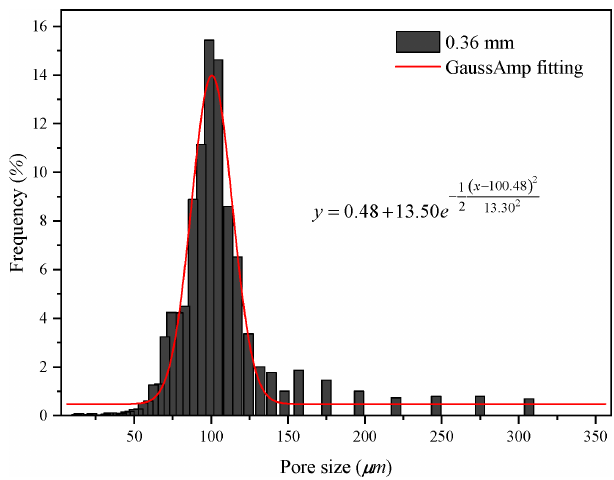
Figure 9. Histogram of the pore size distribution of the permeable stone with a particle diameter of